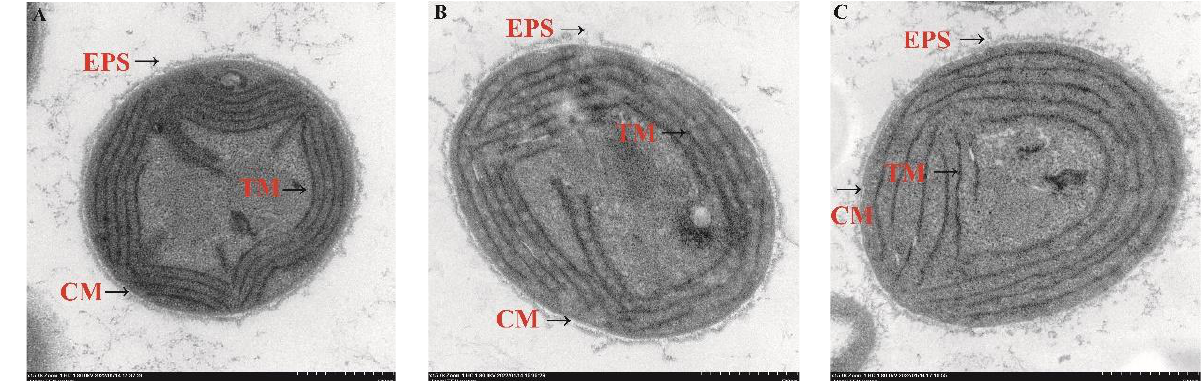
Figure 2. TEM image of algal cells treated with 0.50 mg L −1 cadmium. Thylakoid membrane (TM), cell membrane (CM), and extracellular polymeric substances (EPSs). ( A ) Control group, ( B ) treatment for 24 h, and ( C ) treatment for 72 h.